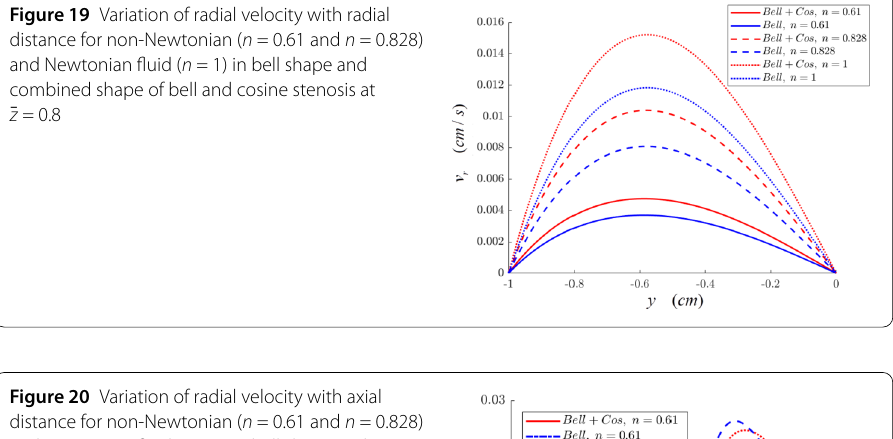
Figure 20 Variation of radial velocity with axial distance for non-Newtonian ( n = 0.61 and n = 0.828) and Newtonian fluid ( n = 1) in bell shape and combined shape of bell and cosine stenosis at y = –0.5